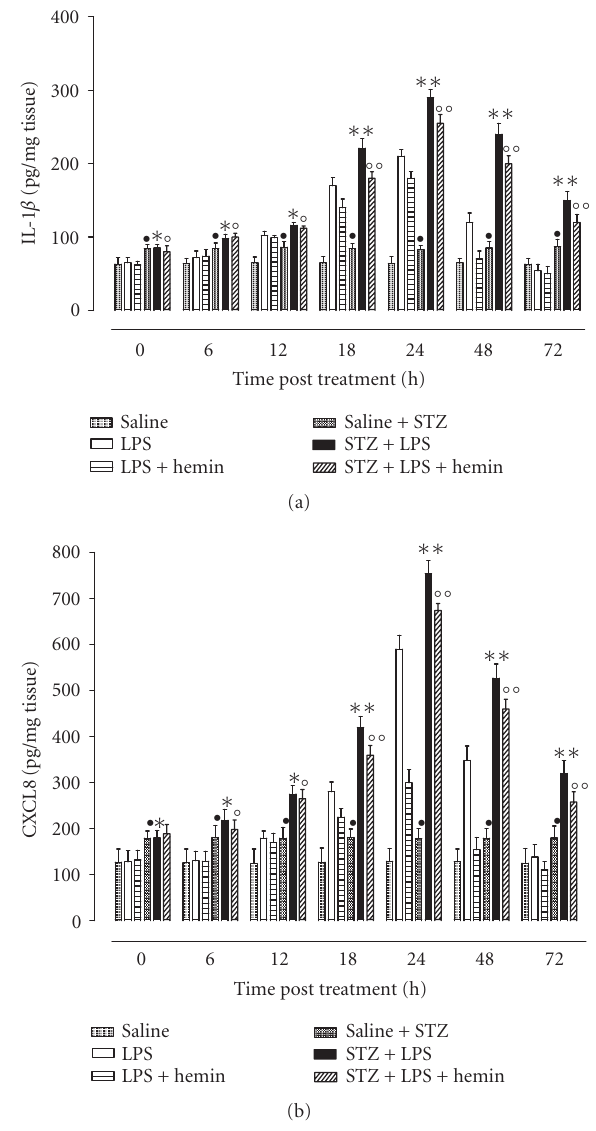
Figure 3: HO-1 induction reduces cytokine levels in the ciliary body. Tissues at each time point of the EIU procedure were col- lected from n = 6 rats for each group and were analysed for IL-1 β or CXCL8 determined by ELISA. Significance is expressed as • P < . 05 versus vehicle saline nondiabetic rats; ∗ P < . 05 and ∗∗ P < . 01 ver- sus. LPS nondiabetic rats; ◦ P < . 05 and ◦◦ P < . 01 versus LPS+hemin nondiabetic